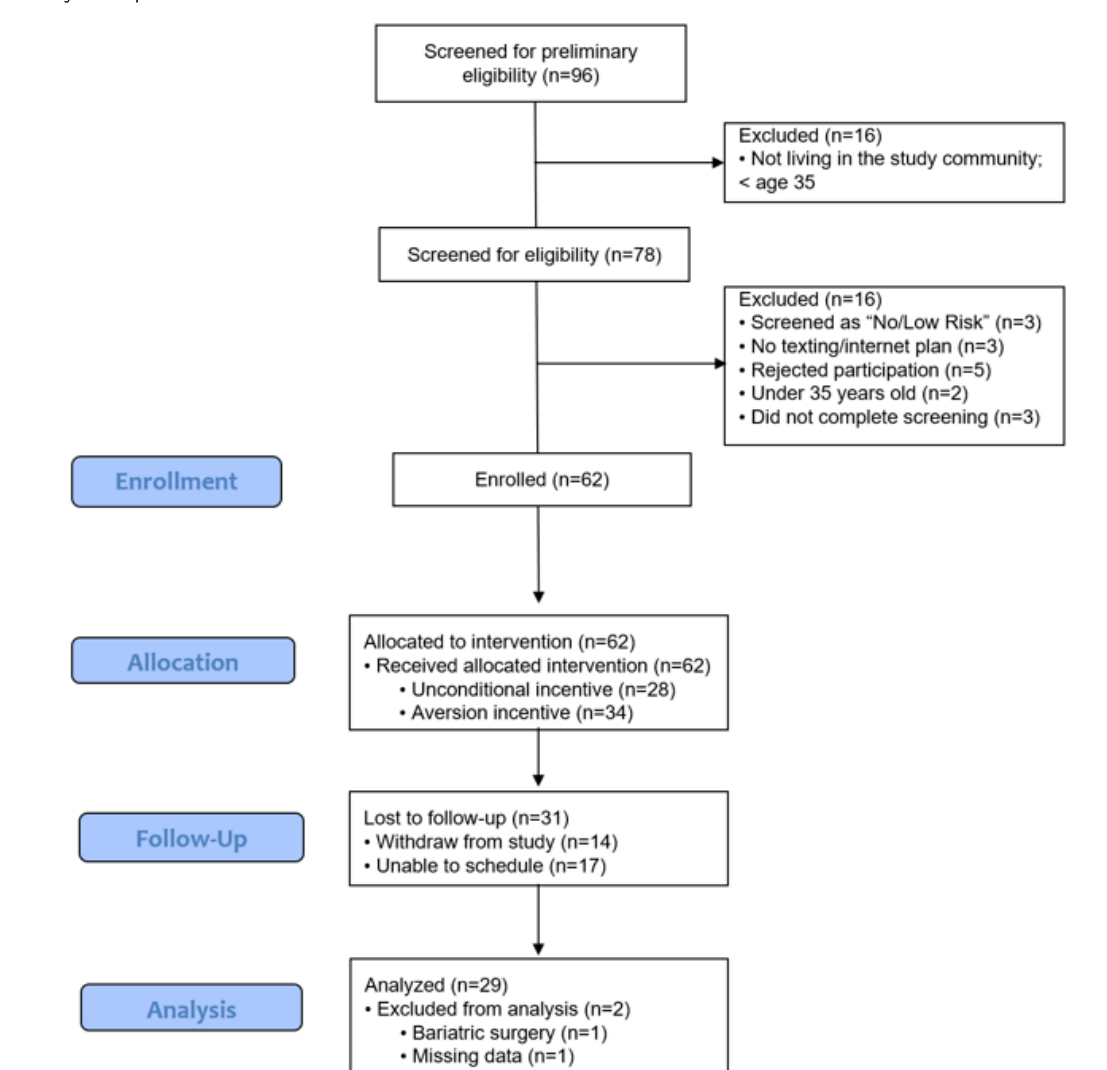
Figure 2. Study Participant